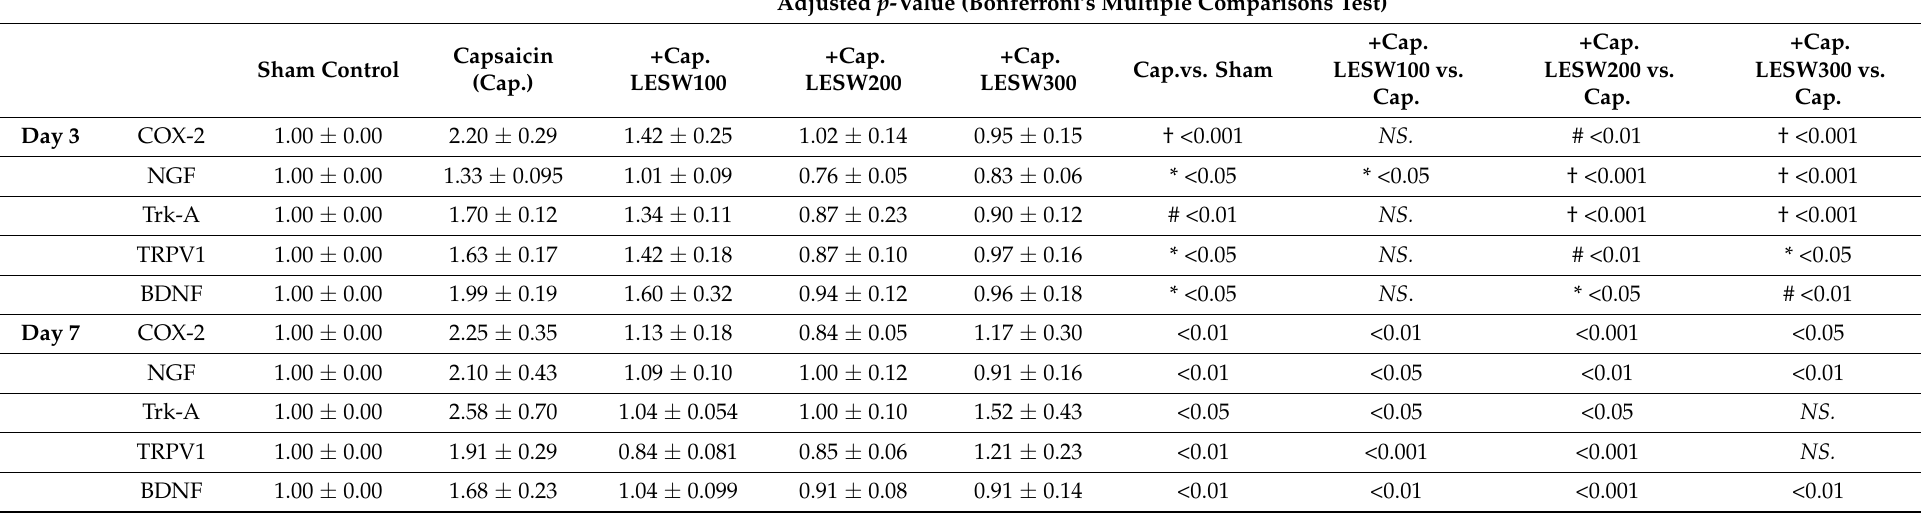
Data presented as the means ± SEM of 10